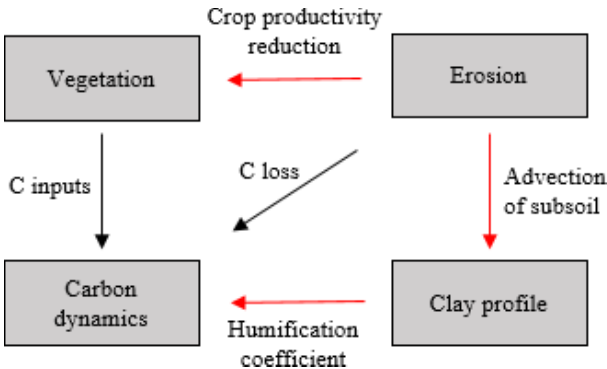
Figure 2. Schematic representation of the model. Black arrows de- pict processes included in published versions of the model (Nadeu et al., 2015) and red arrows represent the new processes included in this study. The humification coefficient is now updated each year according to the evolution of C input in response to soil